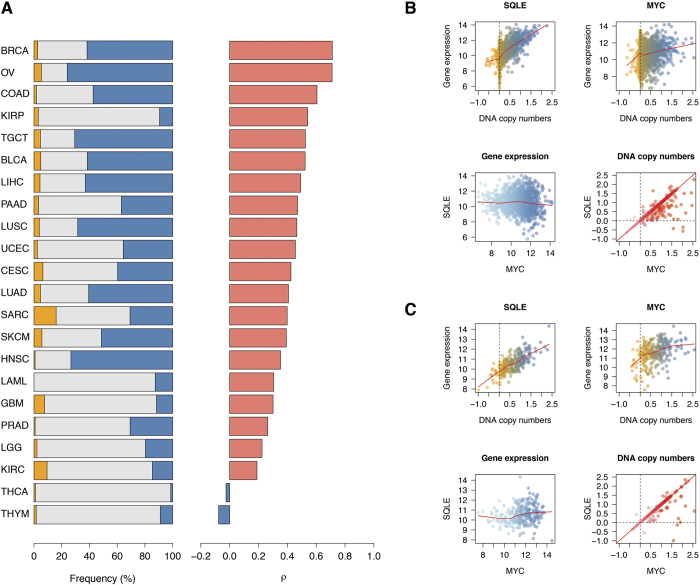
Correlation of SQLE copy number and gene expression is highest in breast and ovarian cancers.All cancer histotypes with at least 100 cases collected by the TCGA were assessed for the presence of SQLE copy number gains and losses (blue and orange respectively, left bar chart (A), and log2 ratios were correlated with normalized SQLE gene expression using the Spearman’s correlation coefficient (ρ value on the x-axis, decreasing from highest to lowest, right bar chart (A). SQLE copy number/gene expression correlation was invariably higher than for MYC, which is physically closely located on chromosome 8q, in both breast (topmost panels, (B) and ovarian cancer (topmost panels, (C). Moreover, SQLE and MYC gene expression values were not correlated in those cancer types (bottom left B and C), whereas copy number values were almost identical due to the aforementioned chromosomal proximity (bottom right B and C). Topmost y-axes and bottom left x- and y-axes C and D: normalized log2 gene expression intensity. Bottom right x- and y-axes C and D: log2 ratios for copy number values. Full definitions of the TCGA acronyms can be found at https://tcga-data.nci.nih.gov/tcga.